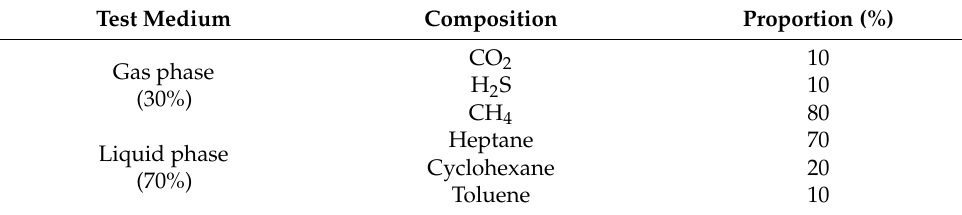
Table 2. The requirements for the test